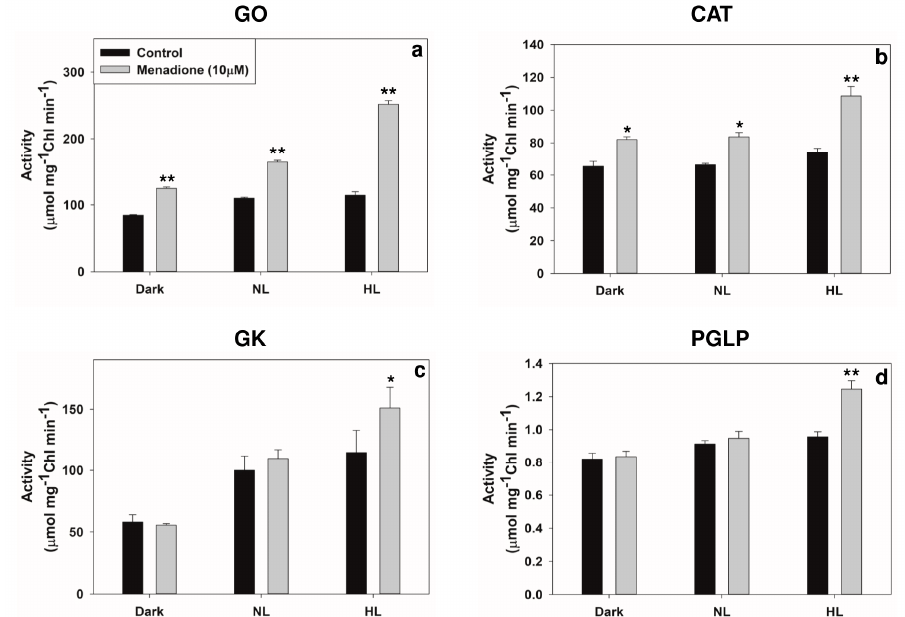
Figure 7. The activities of key photorespiratory enzymes: glycolate oxidase (GO) ( a ), and catalase (CAT) ( b ), glycerate kinase (GK) ( c ), and phosphoglycolate phosphatase (PGLP) ( d ) in leaf extracts from leaf discs on treatment with MD and/or high light. Each data point is the average of three replicates, and error bars represent ±SE. Asterisks indicate the significance of MD effect compared to the respective control. * p < 0.05 ; ** p < 0.001.